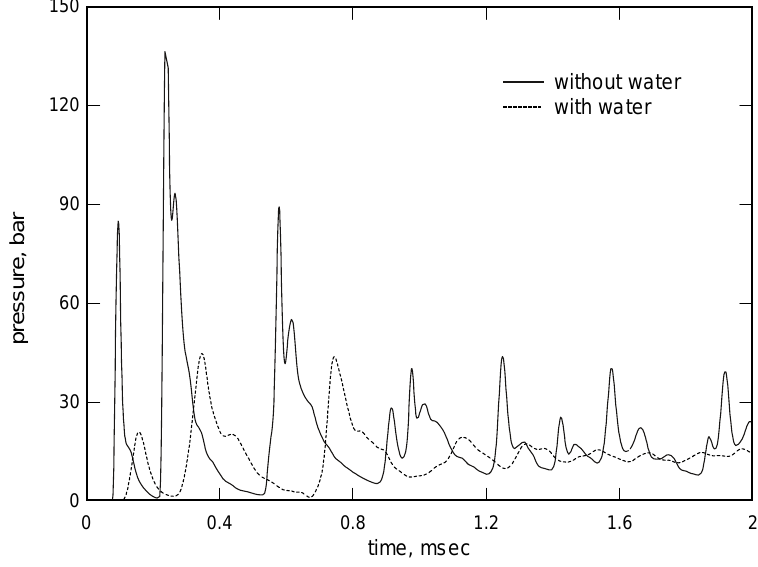
Fig. 3. Numerical simulation of pressure signatures at pressure point P2 in the cube